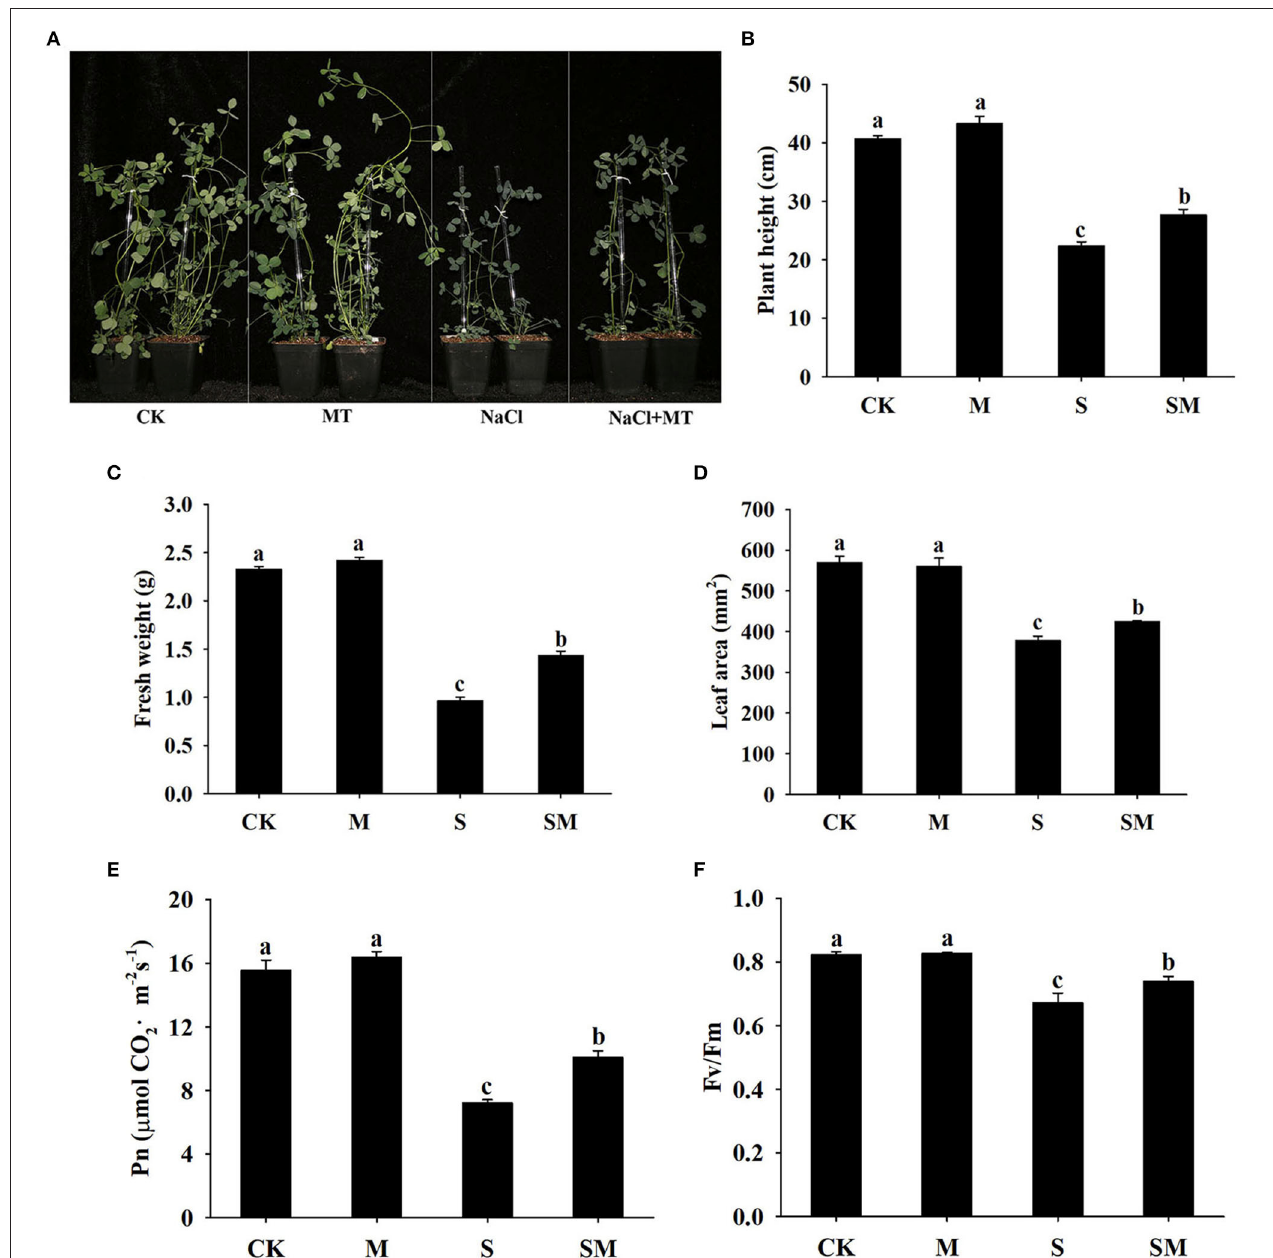
FIGURE 1 | Effect of exogenous melatonin on the phenotype traits and photosynthetic capacity of alfalfa seedlings after 15 day of 150-mM NaCl treatment. (A) The phenotype of a representative individual from each treatment. (B) Plant height. (C) Fresh weight. (D) Leaf area. (E) Net photosynthetic rate (Pn). (F) Fv/Fm. The data are means ± SE ( n = 6) and different letters are significantly different ( p <